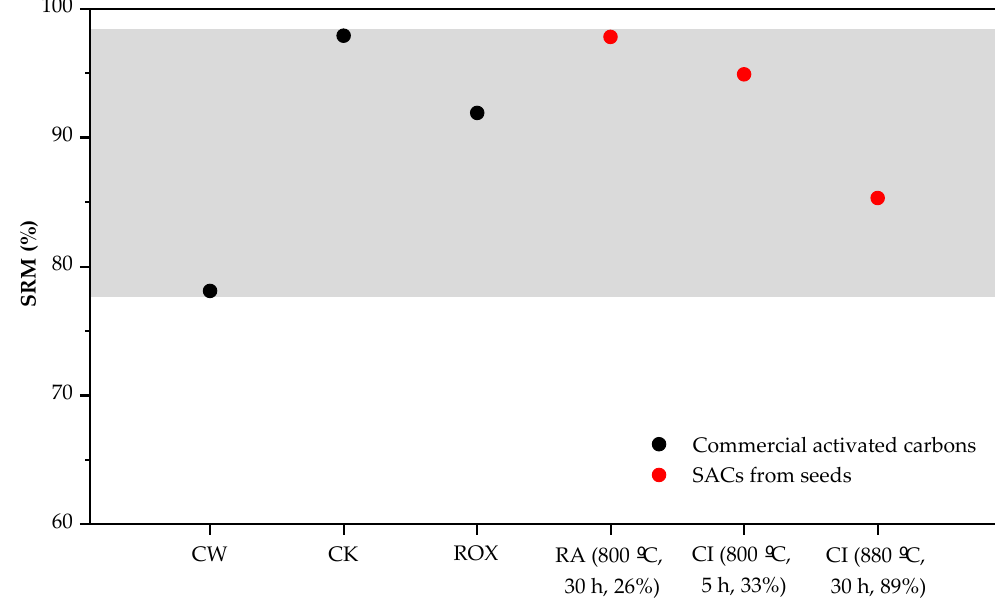
Figure 4. SRM values for commercial activated carbons (black color) and for some activated seeds prepared in this work (orange color).